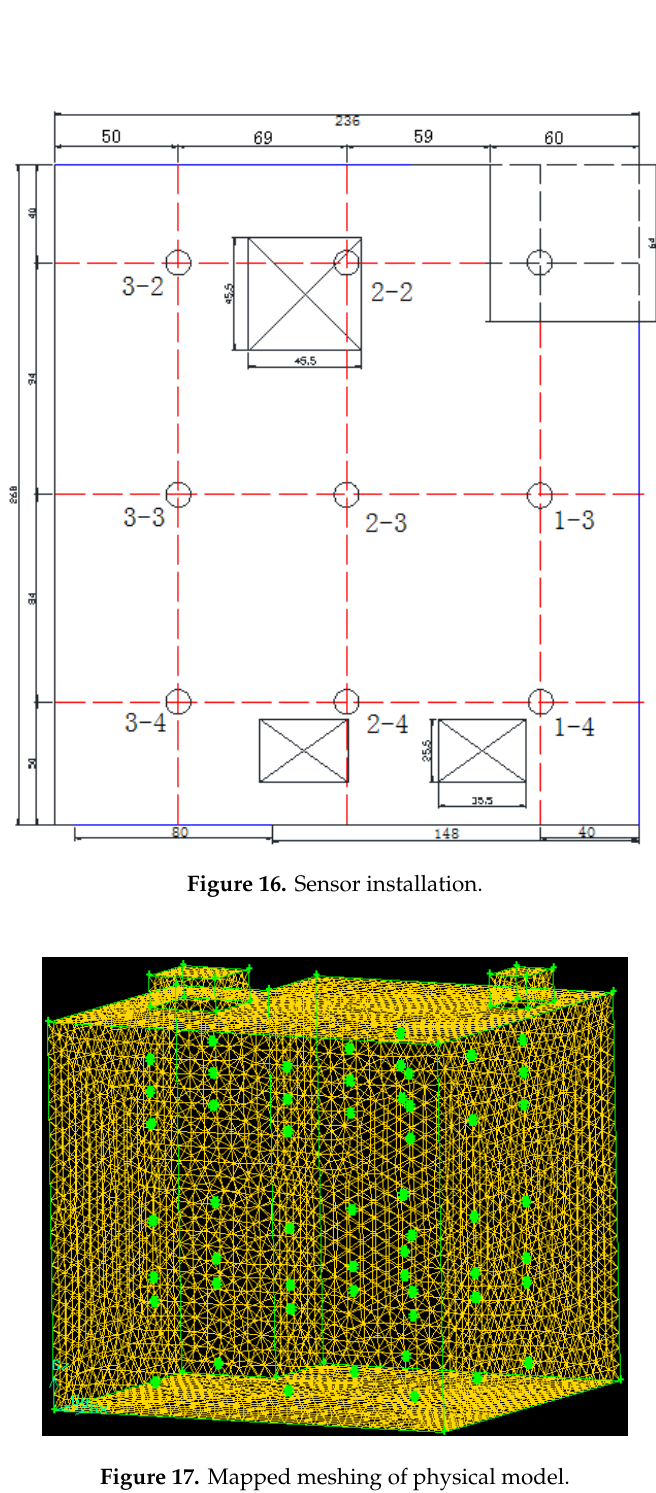
Figure 17. Mapped meshing of physical model.